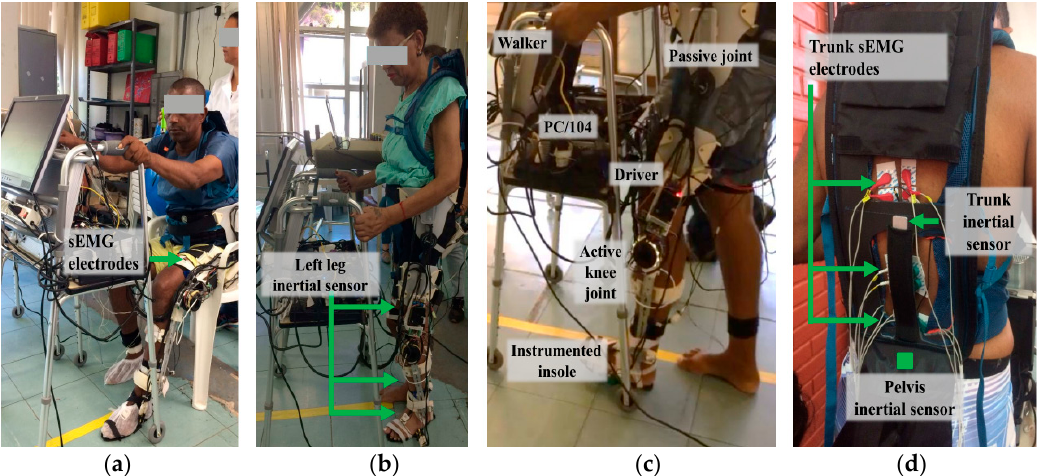
Figure 1. Patients accomplishing the experimental protocol with the exoskeleton plus walker, with surface electromyography (sEMG) and inertial sensors on their trunk. ( a ) sEMG electrodes location on the user’s leg; ( b ) Inertial sensors locations; (c) Location of the instrumented insole, active knee joint, driver, PC / 104 and passive joint of the exoskeleton; ( d ) Location of sEMG eletrodes and inertial sensors on the user’s trunk and